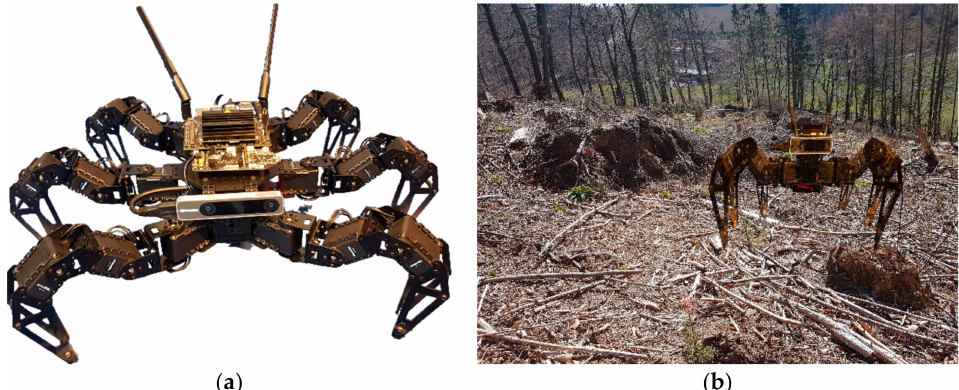
Figure 5. The six-legged walking robot (Hexapod), already developed in the Autonomous Mobile Robotics Lab (AMRL) at the HAWK in Göttingen, is based on the Phantom X platform from Interbotix: ( a ) insect-inspired six-legged robot with multi-sensor navigation frame; ( b ) simulated hexapod in forestry